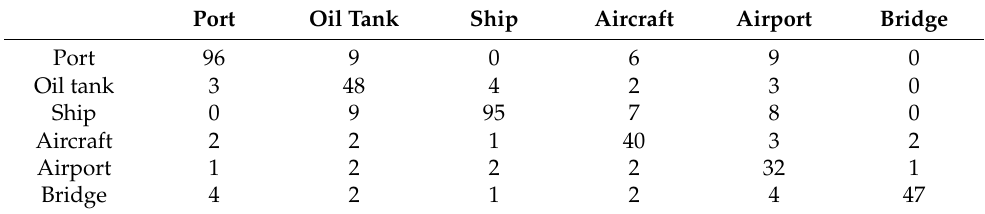
Table 8. Confusion matrix of the proposed target detection network